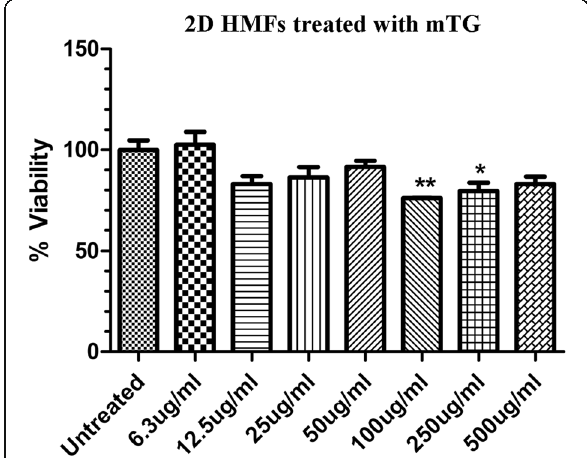
Fig. 1 HMF responses to mTG in 2D culture. HMFs were treated in 2D with various concentrations of mTG. Up to 50 μ g/ml of mTG, viability wasn ’ t significantly different from control, untreated cells. * p ≤ 0.05; ** p ≤ 0.01; *** p ≤